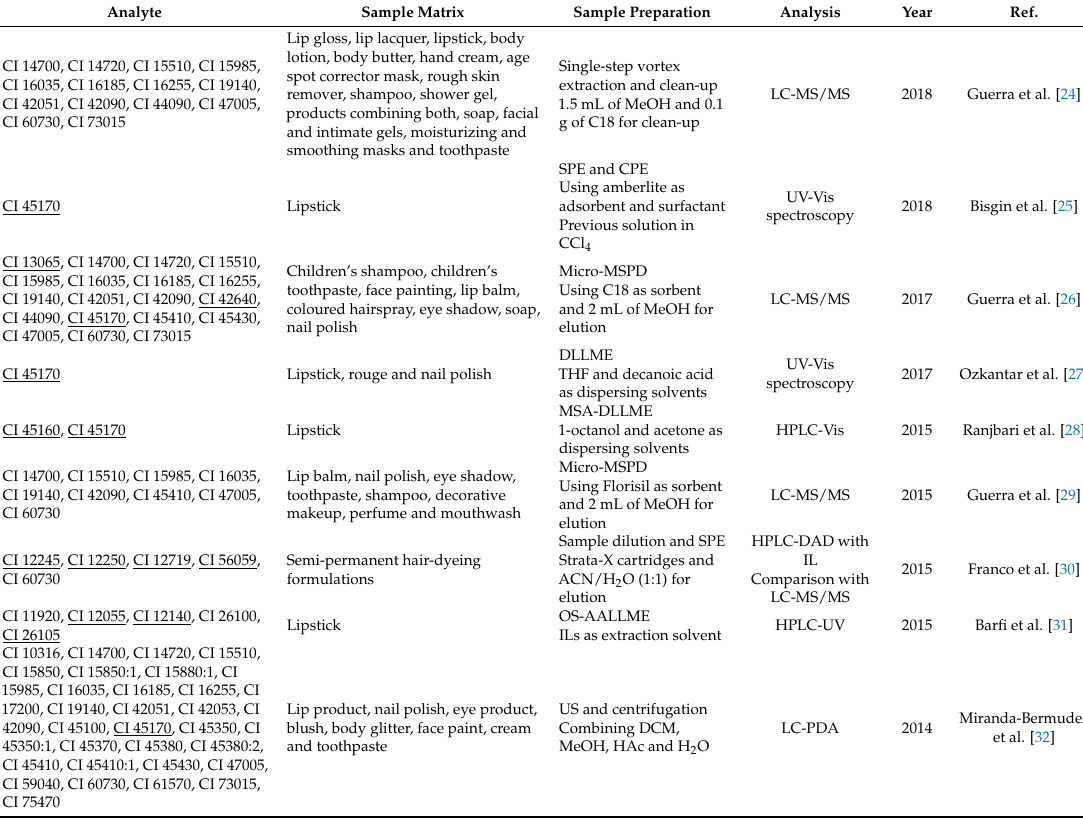
Table 2. Analytical methodologies for dyes in cosmetics published in international scientific literature (2008–2018) (underlined compounds are forbidden according to the European Directive on Cosmetics 1223/2009; abbreviations are listed in Appendix A). Analyte Sample Matrix Sample Preparation spot corrector mask, rough skin remover, shampoo, shower gel, products combining both, soap, facial and intimate gels, moisturizing and smoothing masks and toothpaste SPE and CPE Using amberlite as